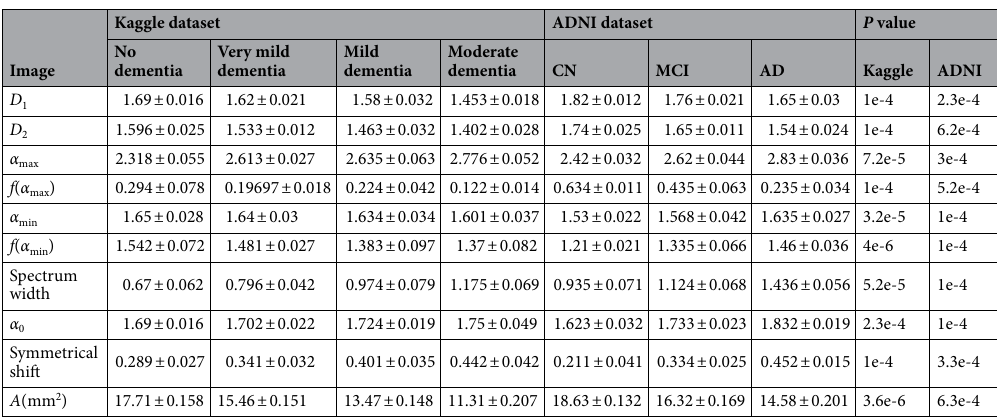
Table 2. The statistical significance of the extracted